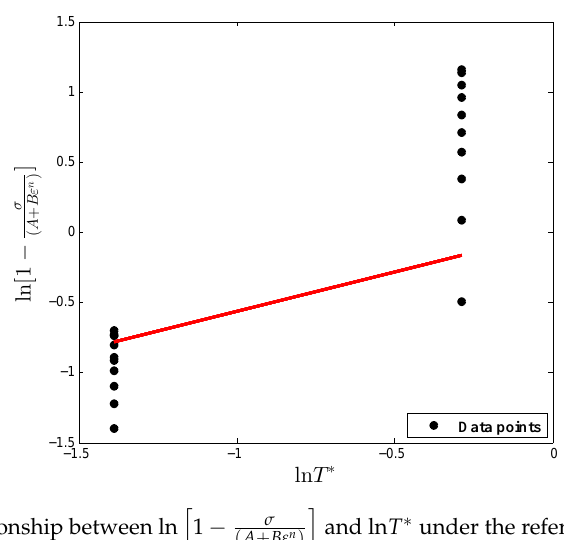
Figure 5. Relationship between ln